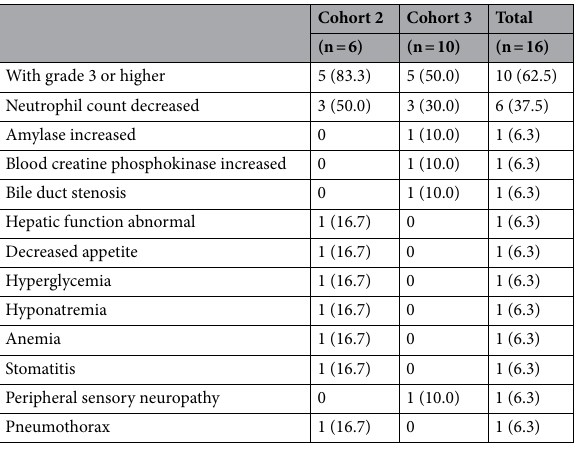
Table 3. Treatment-emergent adverse events (TEAEs) with grade ≥ 3. The safety analysis set includes subjects who received at least one dose of ADX. TEAEs are AEs with onset dates on or after the first dose of study drug ADX and up to 30 days after permanent withdrawal of